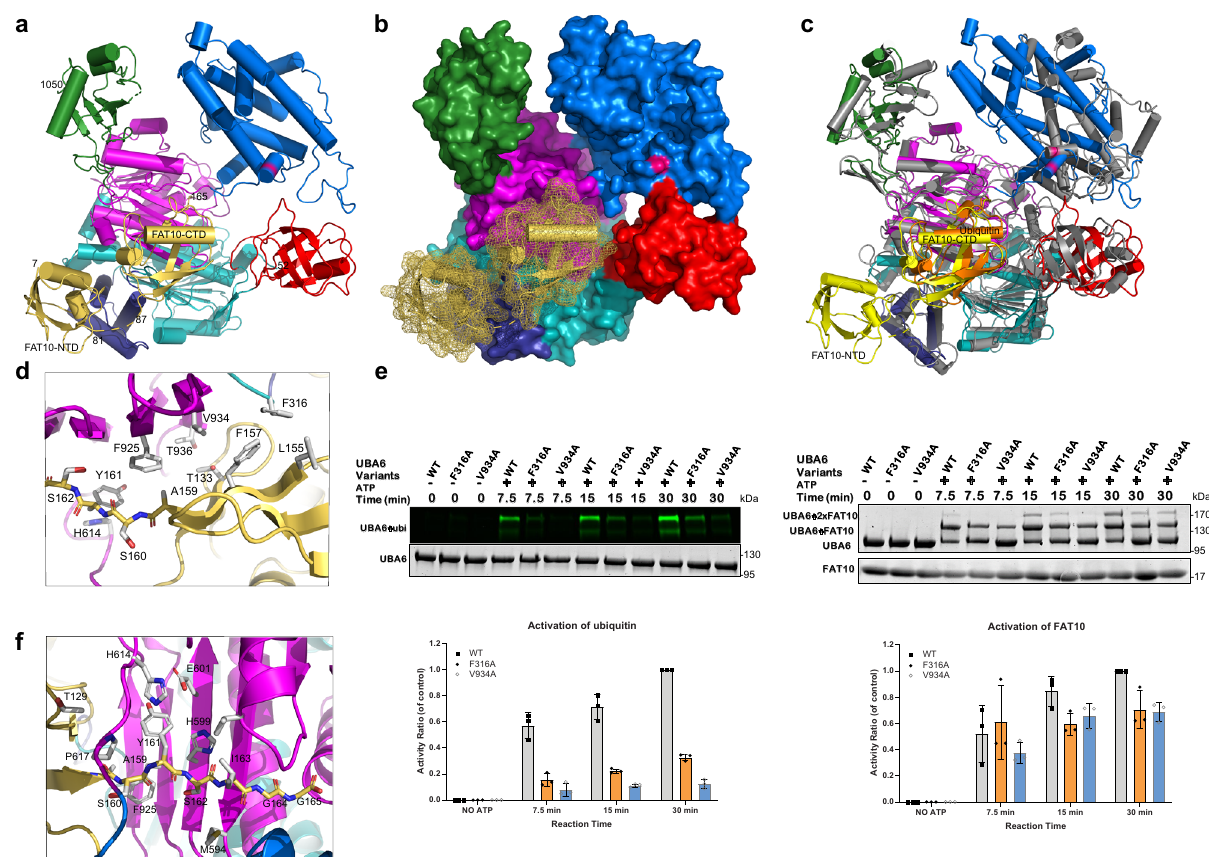
Fig.4|StructureoftheUBA6-FAT10complex.a OverallstructureofUBA6color coded according to its domains in complex with FAT10 in yellow. The NTD and CTD of FAT10 are labeled. b UBA6-FAT10 complex with UBA6 in surface repre- sentation and FAT10 in ribbon and dot representation. c Superimposition of the UBA6-FAT10 complex color coded as in ( a ) and the Uba1-ubiquitin complex with Uba1ingrayandubiquitininorange. d HydrophobicinterfacebetweentheCTDof FAT10 (yellow) and AAD (magenta)/IAD (cyan) of UBA6. Interacting residues are